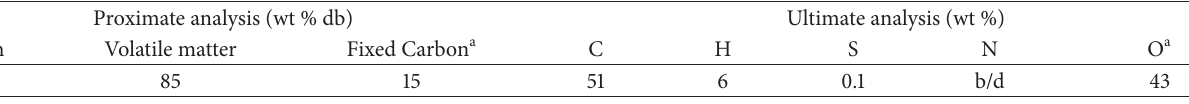
Table 1: Properties of pine tree ( Pinus patula )